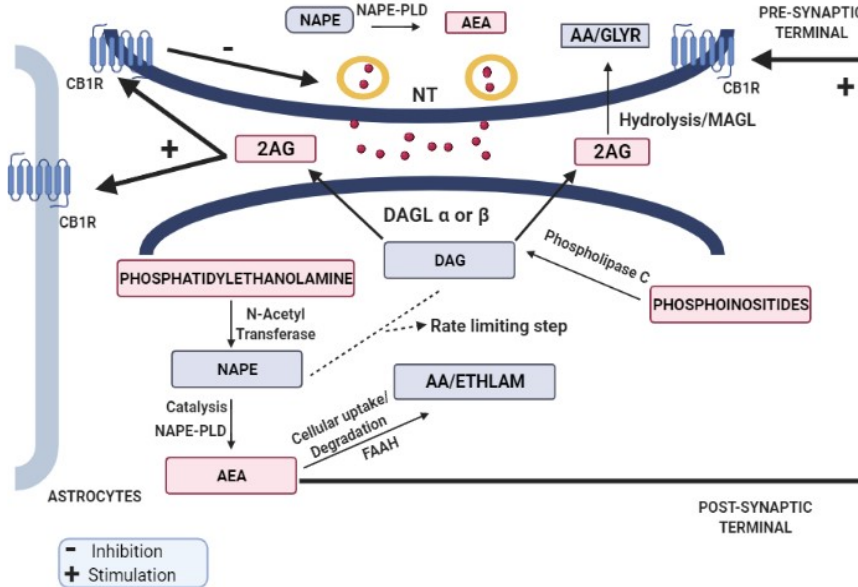
Figure 1. Endocannabinoid retrograde signaling. The endocannabinoids act through a retrograde signaling pathway where cannabinoids are released from depolarized postsynaptic neurons via calcium ‐ dependent mechanism and act in a retrograde fashion on the presynaptic CBRs to inhibit neurotransmitter release.